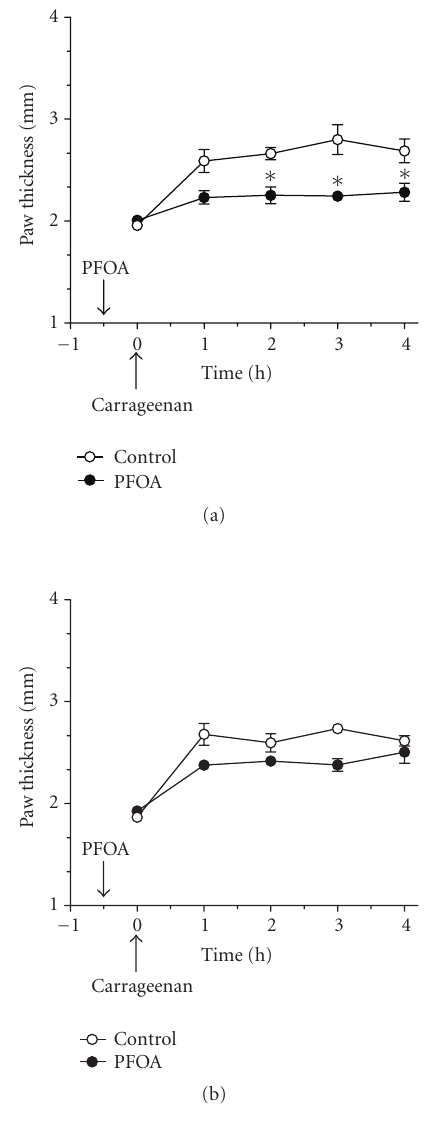
Figure 2: E ff ect of the PPAR α agonist perfluorooctanoic acid (PFOA) on the temporal profile of carrageenan-induced paw edema in wild- type and hepatocyte-specific RXR α -deficient mice. Wild-type (A) and hepatocyte-specific RXR α -deficient mice (B) were treated intraperi- toneally with (100mg/kg) of PFOA, 30 minutes before induction of inflammation. As indicated by the arrow, carrageenan (1%, in- traplantar) was injected at t = 0. Carrageenan-induced edema is reflected by an increase in paw thickness. Values represent mean ± SEM. n = 4 mice per group. ∗ P < . 05 versus corresponding wild- type